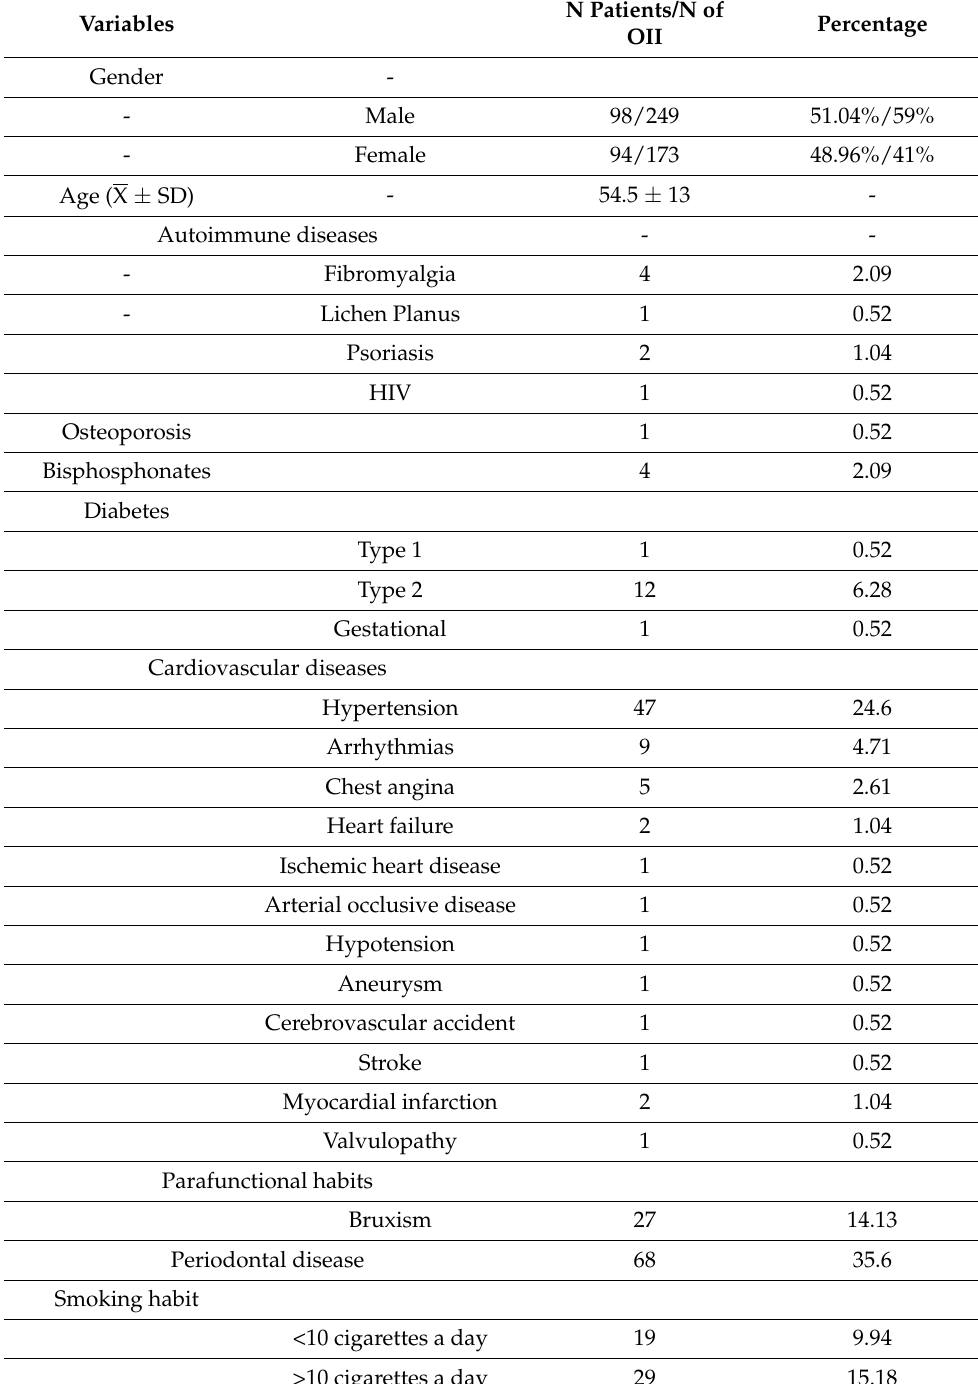
Table 2. Demographic data and medical histories of the sample. N: number; OII: number of implants. HIV: human immunodeficiency virus; NSAIDs: nonsteroidal anti-inflammatories.